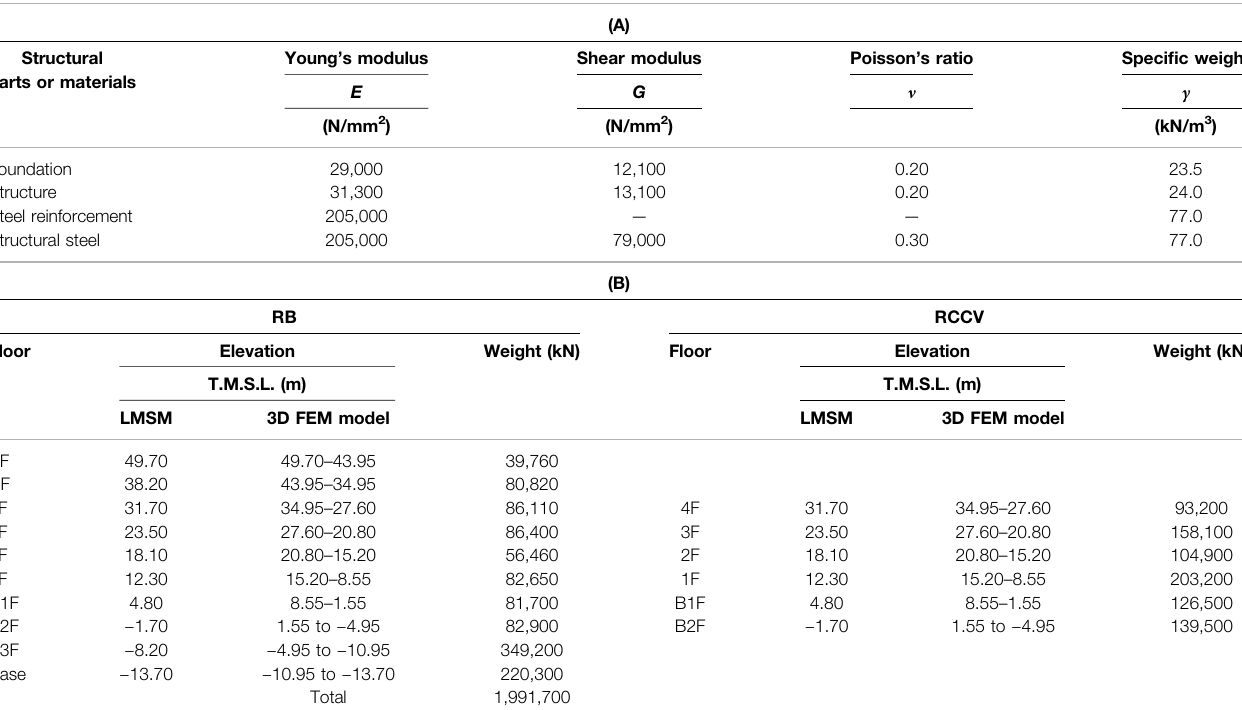
TABLE 1 | Speci fi cations of structural model. (A) Structural material properties. (B) Floor level and weight distribution of LMSM and 3D FEM model.